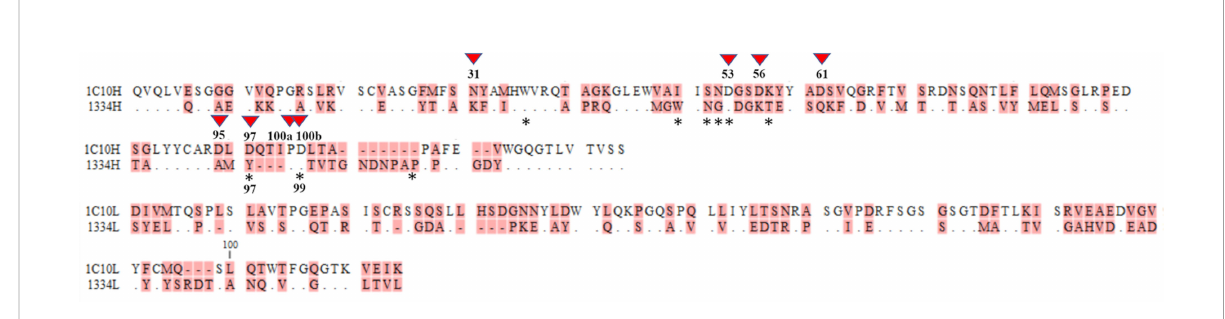
FIGURE 7 Contact residues between the V3 loop and 1C10 and 1334. Contact residues of the 1C10 heavy chain are numbered with down forward arrow heads and those of 1334 are indicated by asterisks. Different amino acids are highlighted in pink, and the same residues are shown by dots. Amino acids are annotated by Kabat numbering. The single asterisk and the double asterisk indicate the elite controller who produced 1C10 and a healthy donor, respectively.